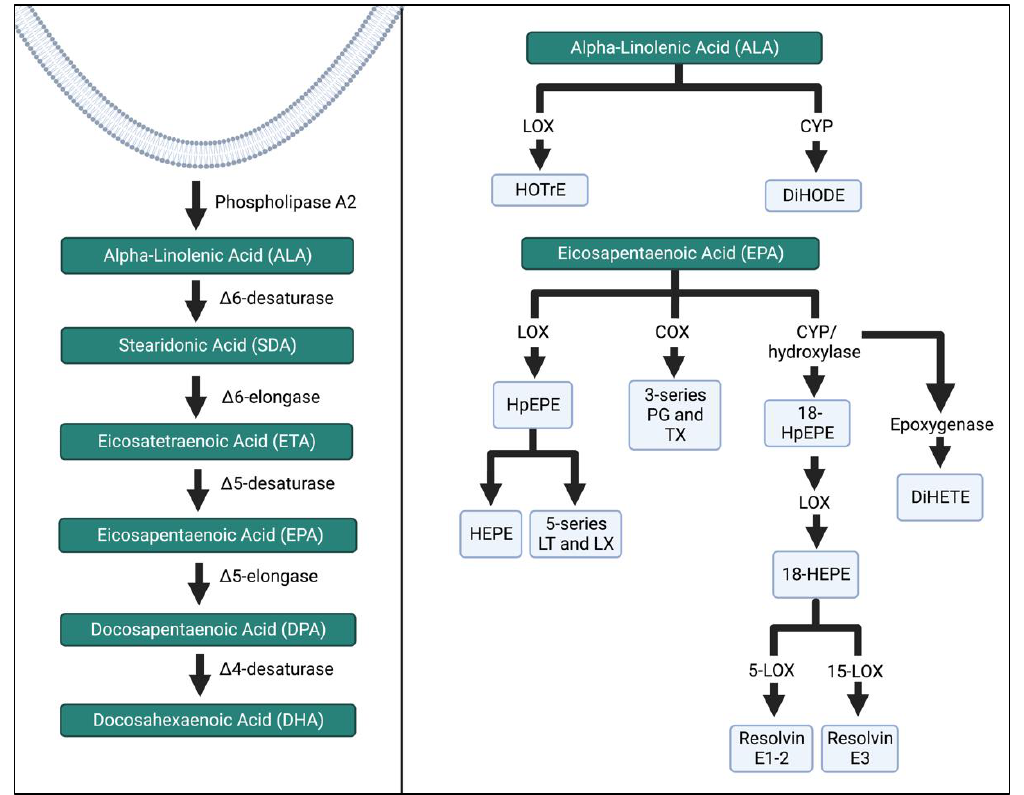
Figure 5. ALA and EPA metabolism by the LOX, COX, and CYP enzymatic pathways. The schema was simplified, and more detailed pathways can be found in the references listed in the Figure above. HOTrE, hydroxy-octadecatrienoic acid; DiHODE, dihydroxy-octadecadienoic acid, HpEPE, hydroperoxyl-eicosapentaenoic acid; HEPE, hydroxyeicosapentaenoic acid; LT, leukotriene; LX, lipoxin; TX, thromboxane; DiHETE, dihydroxy-eicosatetraenoic acid. The Figure was created in Biorender. EPA intermediates and resolvins mediate the effects of the immune system. LOX en- zymatic breakdown of EPA yields the intermediates hydroperoxyl-eicosapentaenoic acid (HpEPE) and hydroxyeicosapentaenoic acid (HEPE) and the bioactive compounds leukotrienes (LT) A-E 5 and lipoxins (LX) A 5 and B 5 . The metabolite 18-HEPE is produced via CYP, and then further LOX activity reduces the adhesion of monocytes to endothelial cells, while also attenuating fibroblast activation. E-series resolvins are produced via further conversion of 18-HEPE. Resolvins E1–3 inhibit and reduce polymorphonuclear leukocyte infiltration